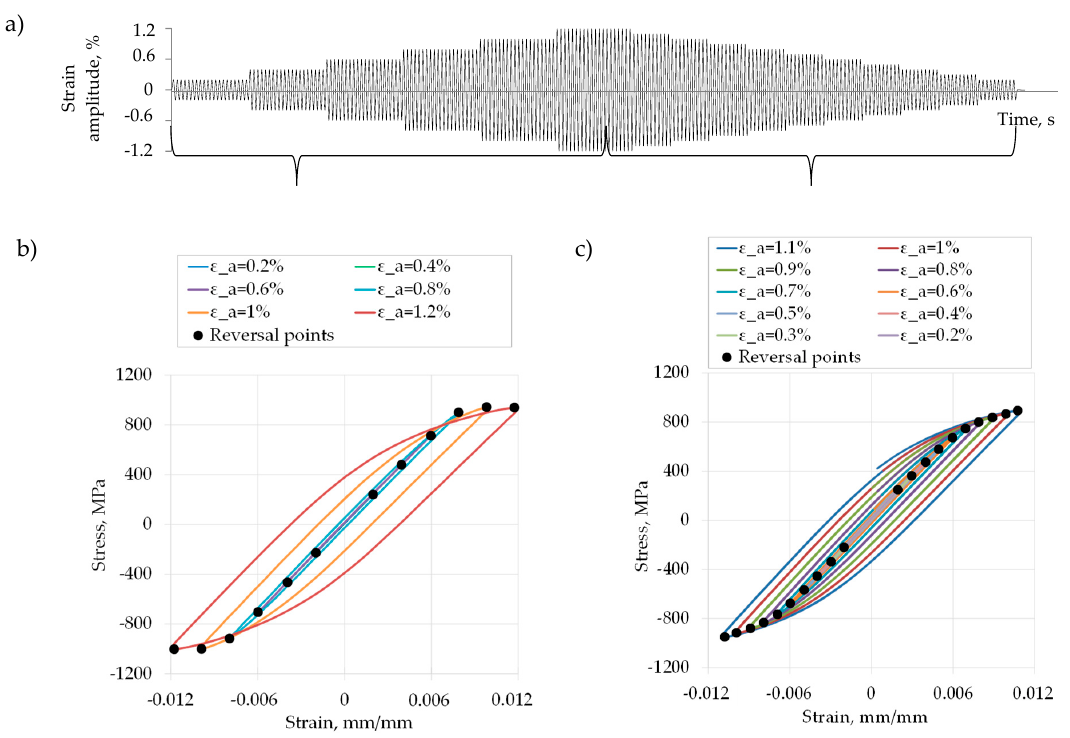
Figure 8. Determination of stress-strain plots from stabilized stress-strain hysteresis of ( a ) multiple step tests distinguished for ( b ) an ascending and ( c ) a descending part. The reversal points are used to determine the cyclic stress-strain curves.